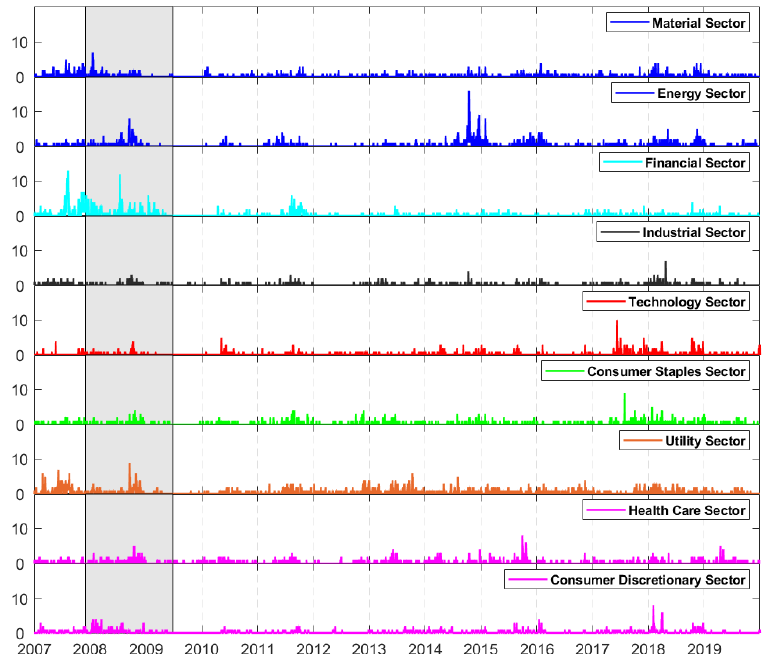
Figure 2. Number of sector-level idiosyncratic jumps: see notes in Figure 1. Figure 2 shows the number of idiosyncratic jumps in nine sectors in the S&P 500 market from January 2007 to December 2019. See Sections 4 and 7 for further